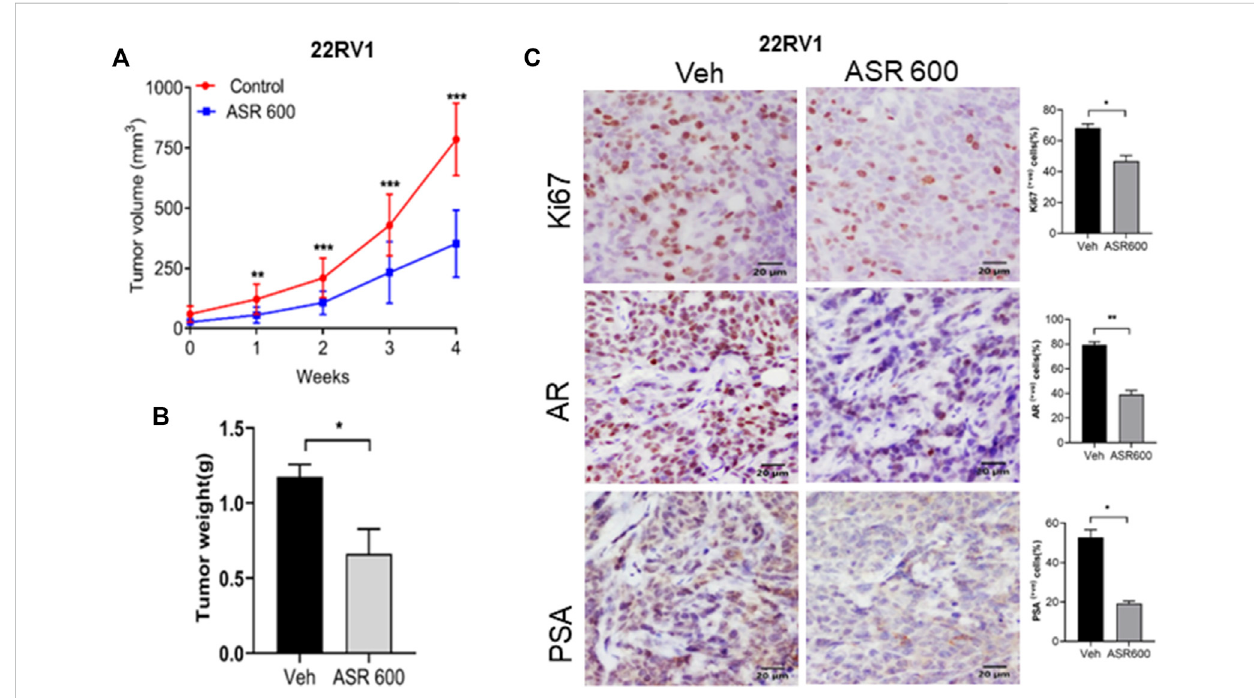
FIGURE 10 Oral administration of ASR-600 inhibits the growth of 22Rv1 xenograft tumors in castrated mice. 22Rv1 cells were inoculated into castrated nude mice. When the tumors reached ~50 mm 3 , the mice were treated with 20 mg/kg ASR-600 through oral gavage. (A) . Mean tumor volumes. (B) , Individual tumor weight was measured. (C) . Immunohistochemistry analyses of tumor samples were performed to evaluate the expression of Ki67, AR and PSA in 22Rv1 xenografted